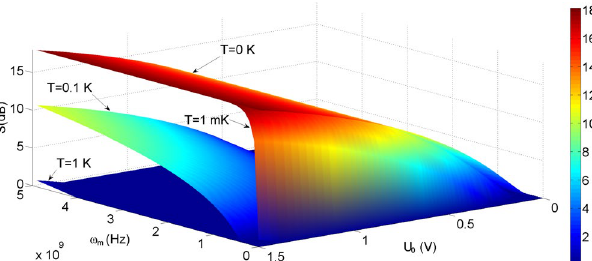
Figure 2. The degree of the squeezing S versus the frequency and the voltage for different temperatures of the environment T = 0 K, 1 mK, 0.1 K, 1 K when C 0 = 5 nF, r 0 = 4 μ m, and the elastic coefficient ω = = k m 22